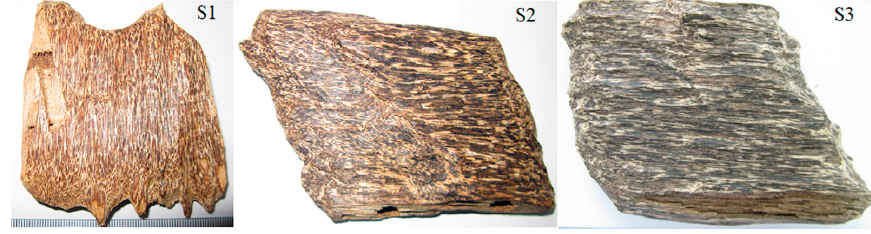
Figure 5. Pictures of the three batches of agarwood.